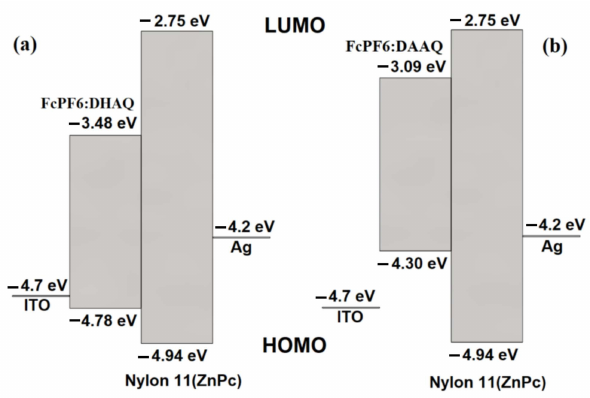
Figure 5. Energy levels of ( a ) FcPF 6 :DHAQ/nylon(ZnPc) and ( b ) FcPF 6 :DAAQ/nylon(ZnPc)